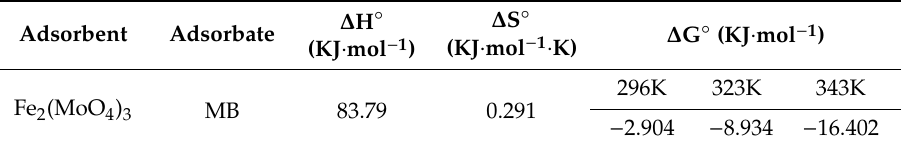
Table 2. Kinetic model equations.